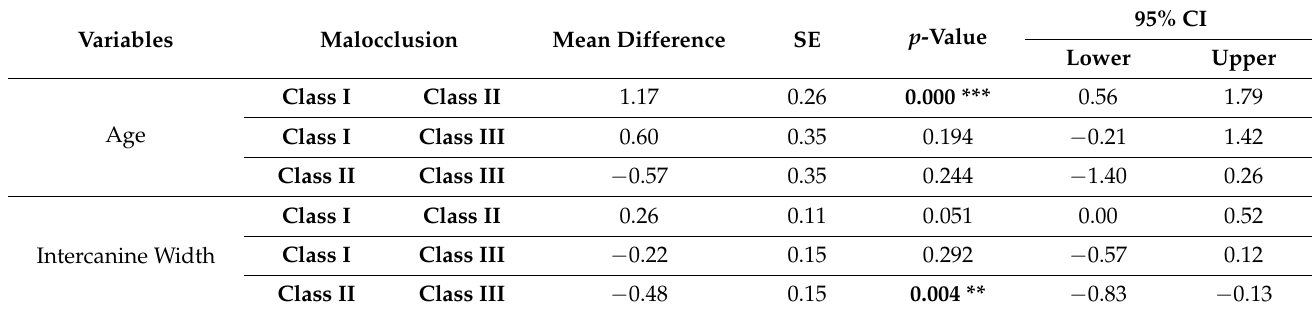
Table 10. Post hoc Tukey HSD test showing the comparison of age and arch dimensions bet- ween